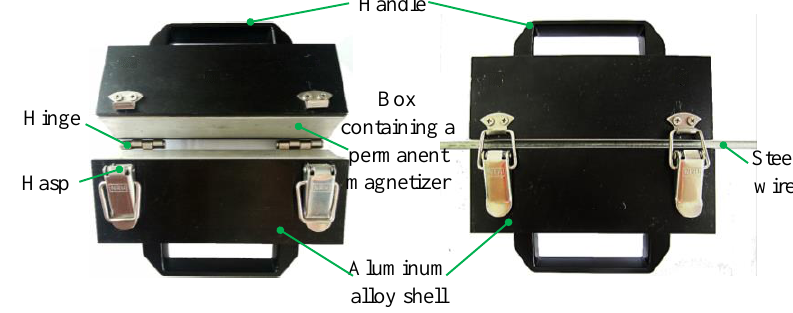
Figure 6. The developed static magnetization unit.